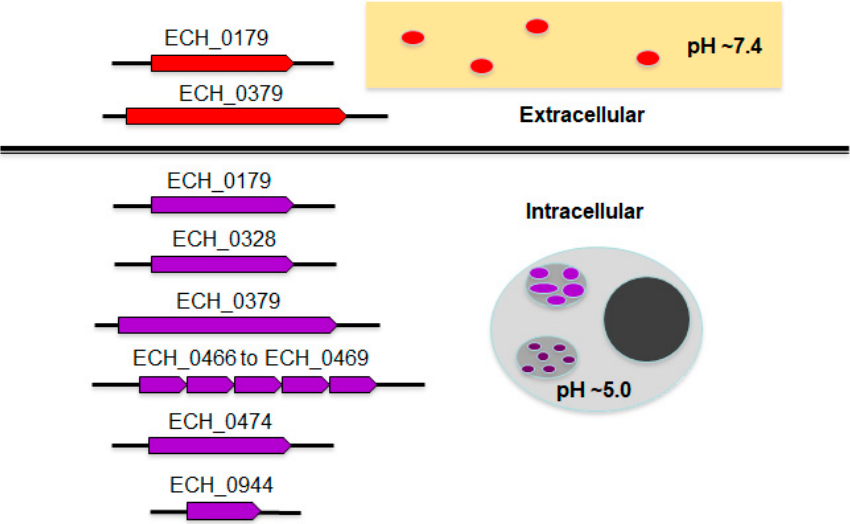
Figure 8. Model cartoon outlining E. chaffeensis antiporters for their possible roles in pH homeostasis in the Ehrlichia -containing acidified phagosomes and during the release of the DC form in the extra- cellular